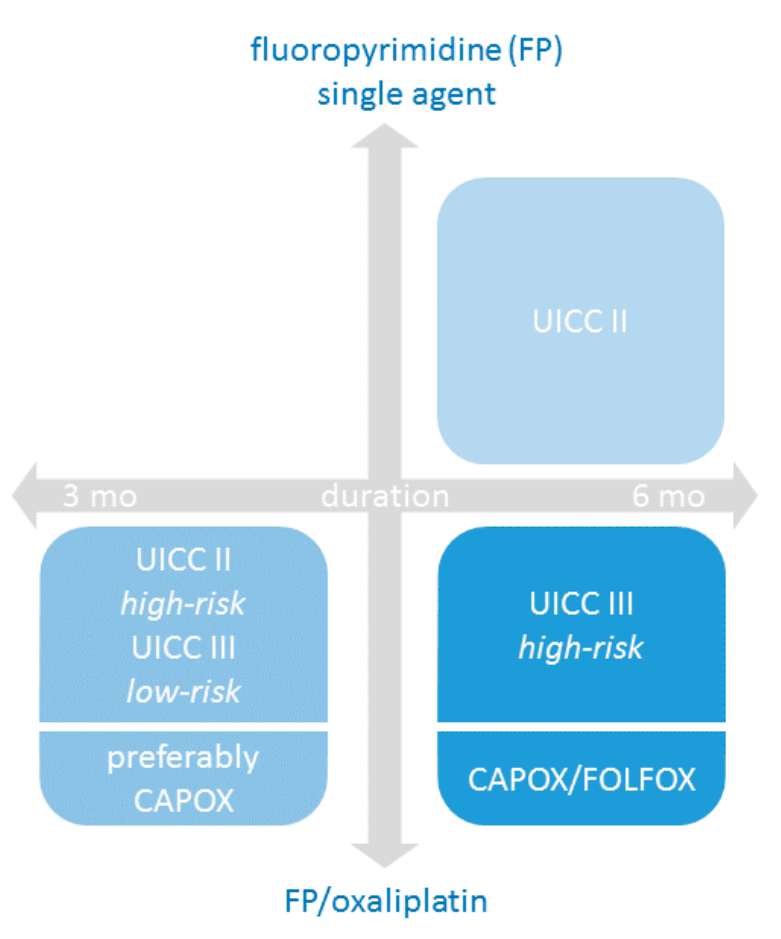
Figure 2. Recommendation for adjuvant chemotherapy in UICC II and III colon cancer depended on treatment duration, treatment intensity and clinical risk factors.